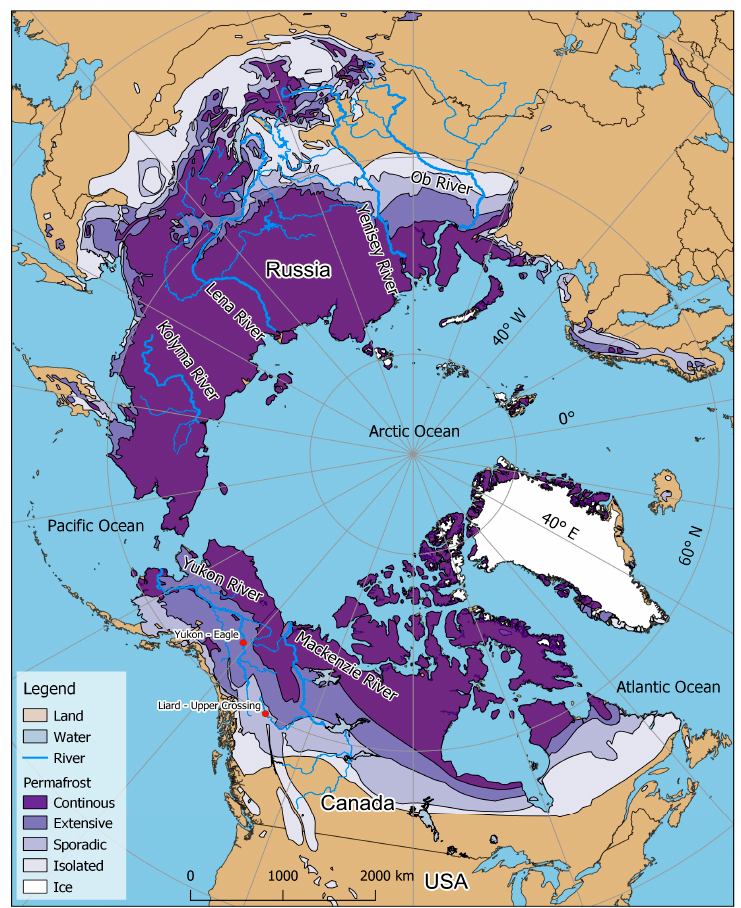
Figure A1. Map showing the six large Arctic flowing rivers summarized in Table 1 (Kolyma, Lena, Yenisey, Ob, Mackenzie, and Yukon). Red dots indicate the location of two hydrometric stations: ( 1 ) Yukon River at Eagle (Yukon-E) and ( 2 ) Liard River at Upper Crossing (Liard-UC); for which detailed analyses of climatic controls on streamflow extremes were conducted.